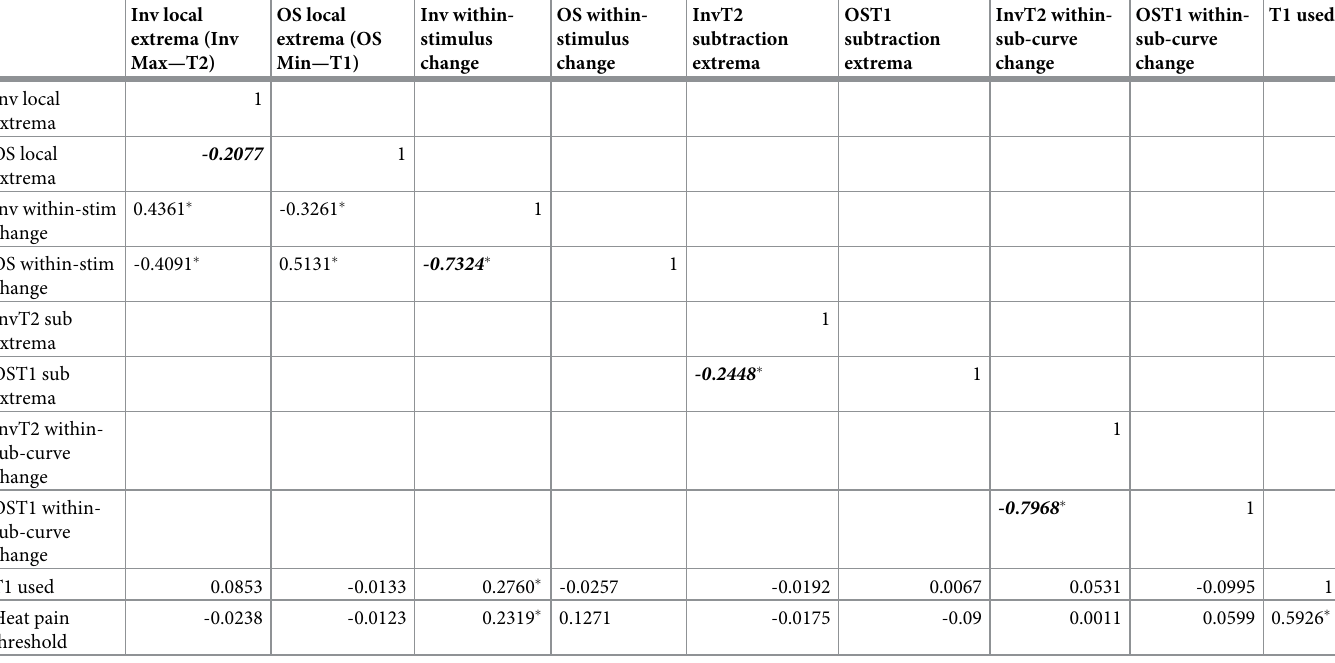
Pearson r values for each pair-wise comparison are shown. Bold italic font denotes comparisons between different measures of onset hyperalgesia (using the Inv stimulus protocol) and offset analgesia (using the OS protocol). � p <